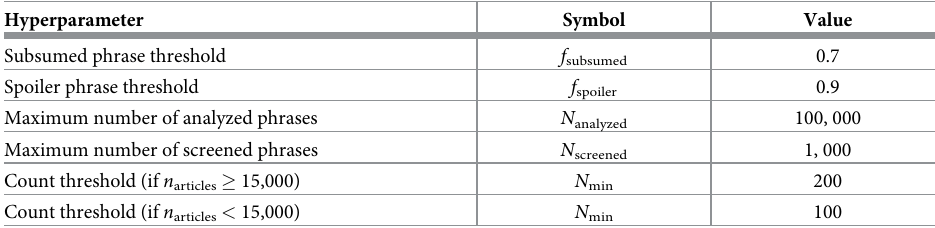
Table 1. Summary of hyperparameters